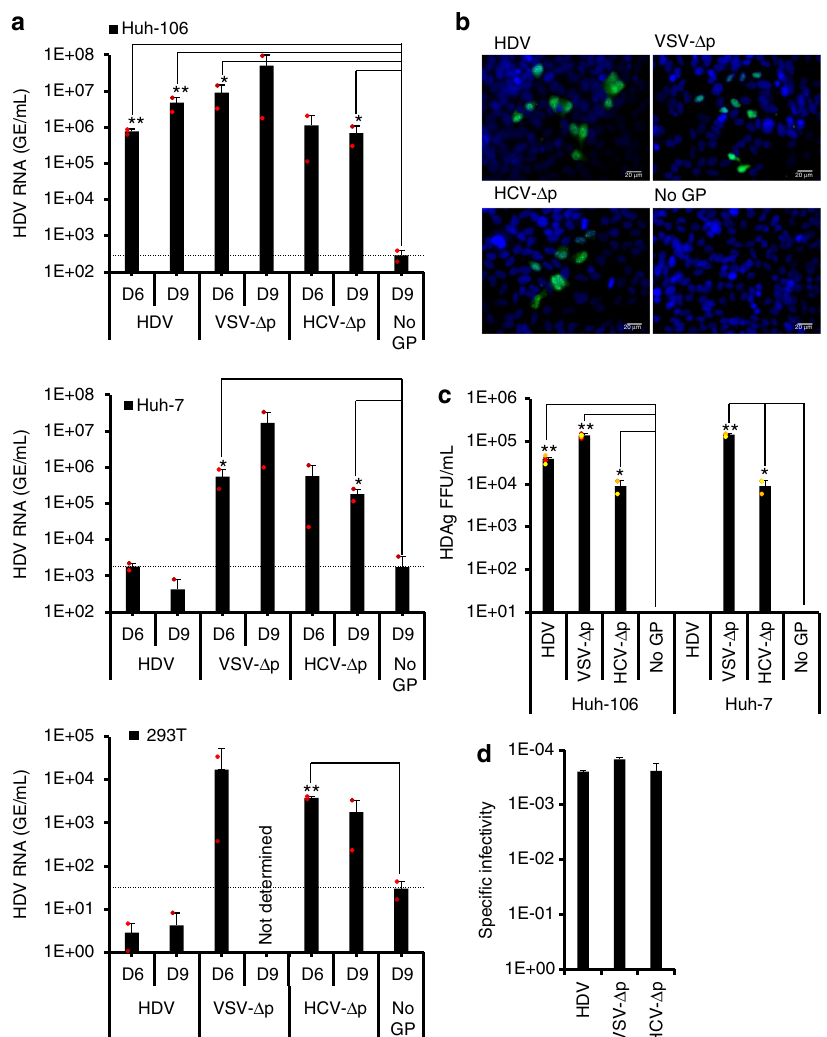
Fig. 2 HDV particles generated with heterologous envelope glycoproteins are infectious. a The infectivity of virus particles produced with HBV (HDV), VSV (VSV- Δ p), HCV (HCV- Δ p) glycoproteins, or with no envelope glycoprotein (No GP) and harvested at day 6 or 9 post transfection (see Fig. 1a) was determined in Huh-106 (NTCP-expressing Huh-7 cells), Huh-7, or 293T cells, as indicated. Infected cells were grown for 7 days before total intracellular RNA was puri fi ed. The results of HDV RNA quanti fi cation by RT-qPCR are expressed as means ( n = 2 independent experiments) per mL of cell lysates containing 10 5 cells. Nd, not determined. The dotted lines represent the experimental thresholds, as de fi ned with the “ No GP ” controls. b , c Huh-106 and Huh-7 cells infected by serial dilutions of supernatants containing the indicated virus particles harvested at day 9 post transfection (Fig. 1a) were fi xed at 7 days post infection and stained by immuno fl uorescence with the SE1679 polyclonal anti-HDAg antibody before counting the foci of HDAg-positive cell colonies. The cells were counterstained with Hoechst to visualize the nuclei. Scale bars represent 20 µ m ( b ). The results from colony counting are expressed as means ( n = 4 independent experiments) of FFU per mL of cell supernatants ( c ). d The speci fi c infectivity values of the indicated viruses determined in Huh-106 infected cells were calculated from the experiments shown in c using the infectious titers and the HDV RNA contents of the inoculums. The results show the ratios of HDAg-positive FFU induced by HDV RNA from the same inoculums. Source data are provided as a Source Data fi le. Error bars correspond to standard deviation. Statistical analyses (Student ’ s t- test): p < 0.05 (*); p < 0.01 acid (TCA) speci fi cally inhibited infection of Huh-106 cells with Hence, we co-transfected pSVLD3 with plasmids encoding the HDV particles produced with HBV GPs, as expected 12 , antibodies GPs from RD114 cat endogenous virus, murine leukemia virus against LDLr and CD81 (i.e., one of the HCV receptors) blocked the entry of VSV- Δ p and HCV- Δ p particles, respectively, though LDLr antibodies exhibited some nonspeci fi c levels of inhibition. Altogether, the results of virus-neutralization and receptor- blocking assays indicated that the conformation of the surface (Fig. 5a). We detected the secretion of HDV particles induced by of VSV- Δ p and HCV- Δ p particles is similar to that of parental the GPs from HMPV, DENV, and WNV at levels similar to those viruses and able to mediate GP-speci fi c cell entry through their of HBV GPs and at lower levels with the GPs from LCMV, corresponding receptors. though not with the GPs from the other viruses (Fig. 5b). Thereafter, we explored if HDV particles could be produced Importantly, while no infectivity could be detected in the with envelope GPs from a broader set of enveloped viruses. supernatants from the latter GPs, HDV particles enveloped with